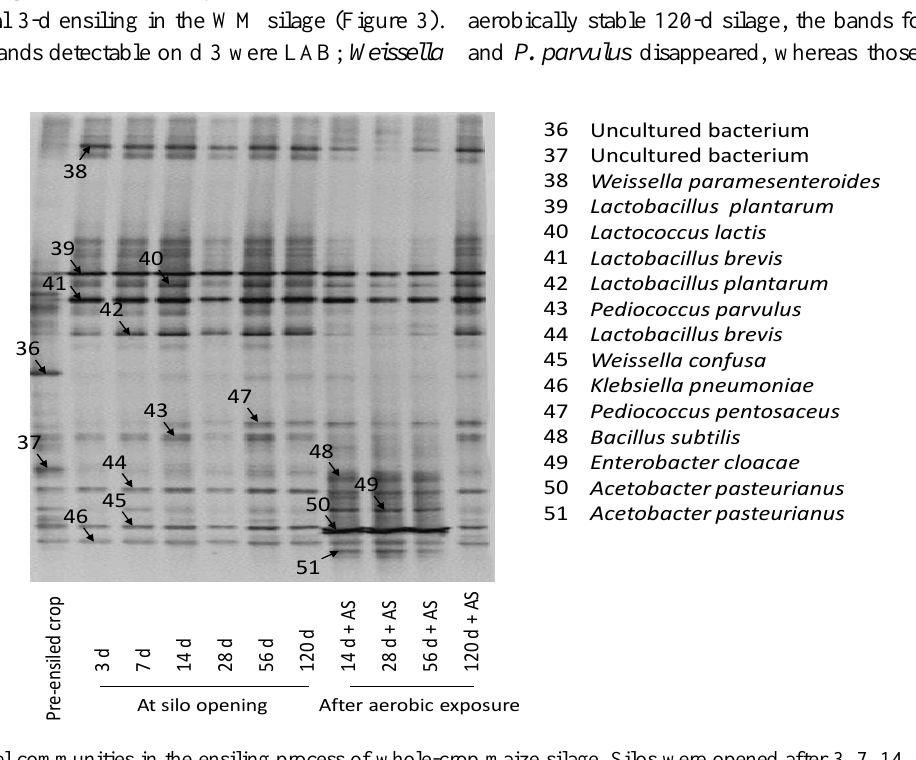
Figure 3. Bacterial communities in the ensiling process of whole-crop maize silage. Silos were opened after 3, 7, 14, 28, 56, and 120 d and a 7-d aerobic stability test was conducted for the silages from the latter 4 silages.